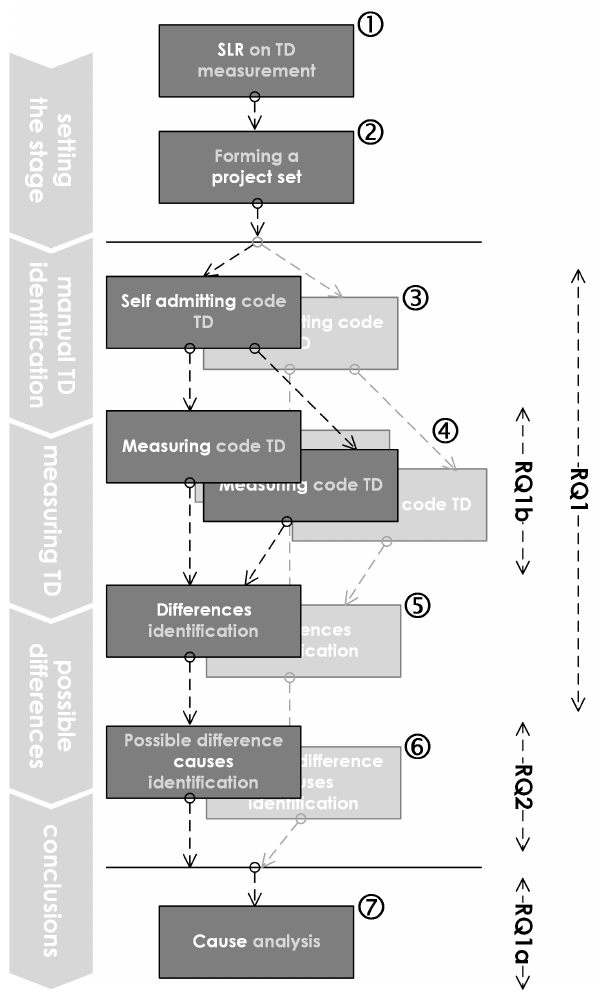
Figure 1. Research Method